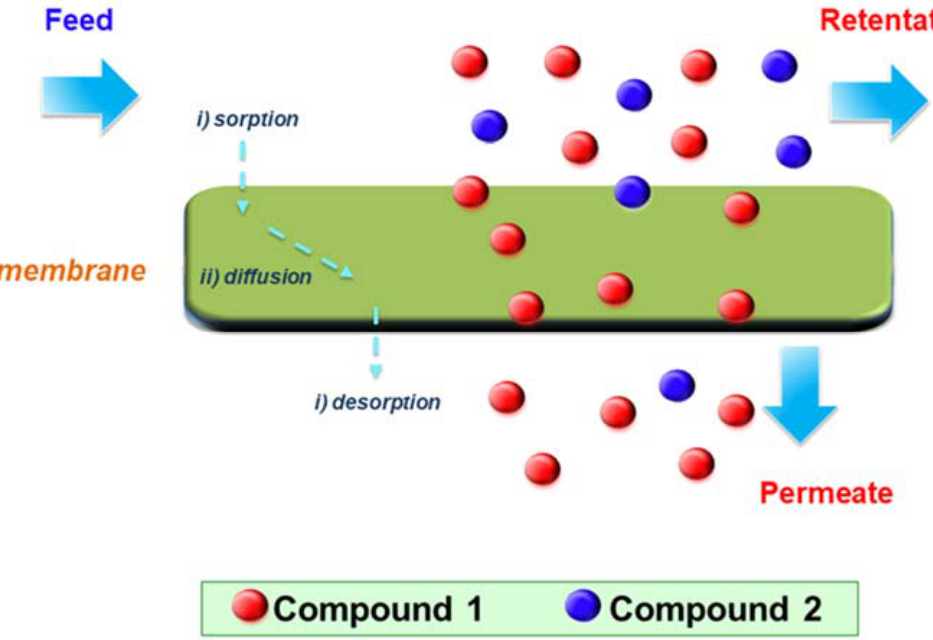
Figure 3. Mass transfer in pervaporation: description of solution ‐ diffusion mechanism.